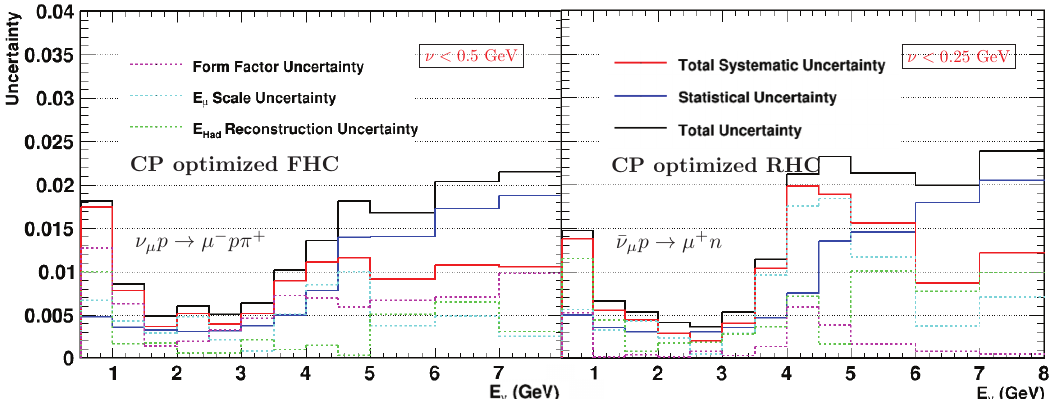
Figure 142. Left panel: expected statistical and systematic uncertainties in the ν µ relative flux determination using ν µ p µ − p π + exclusive processes on hydrogen assuming 5 year of data taking with the full STT detector option in → SAND [51].Right panel: same as the previous for the ¯ ν µ relative flux determination using ¯ ν µ p on hydrogen in STT